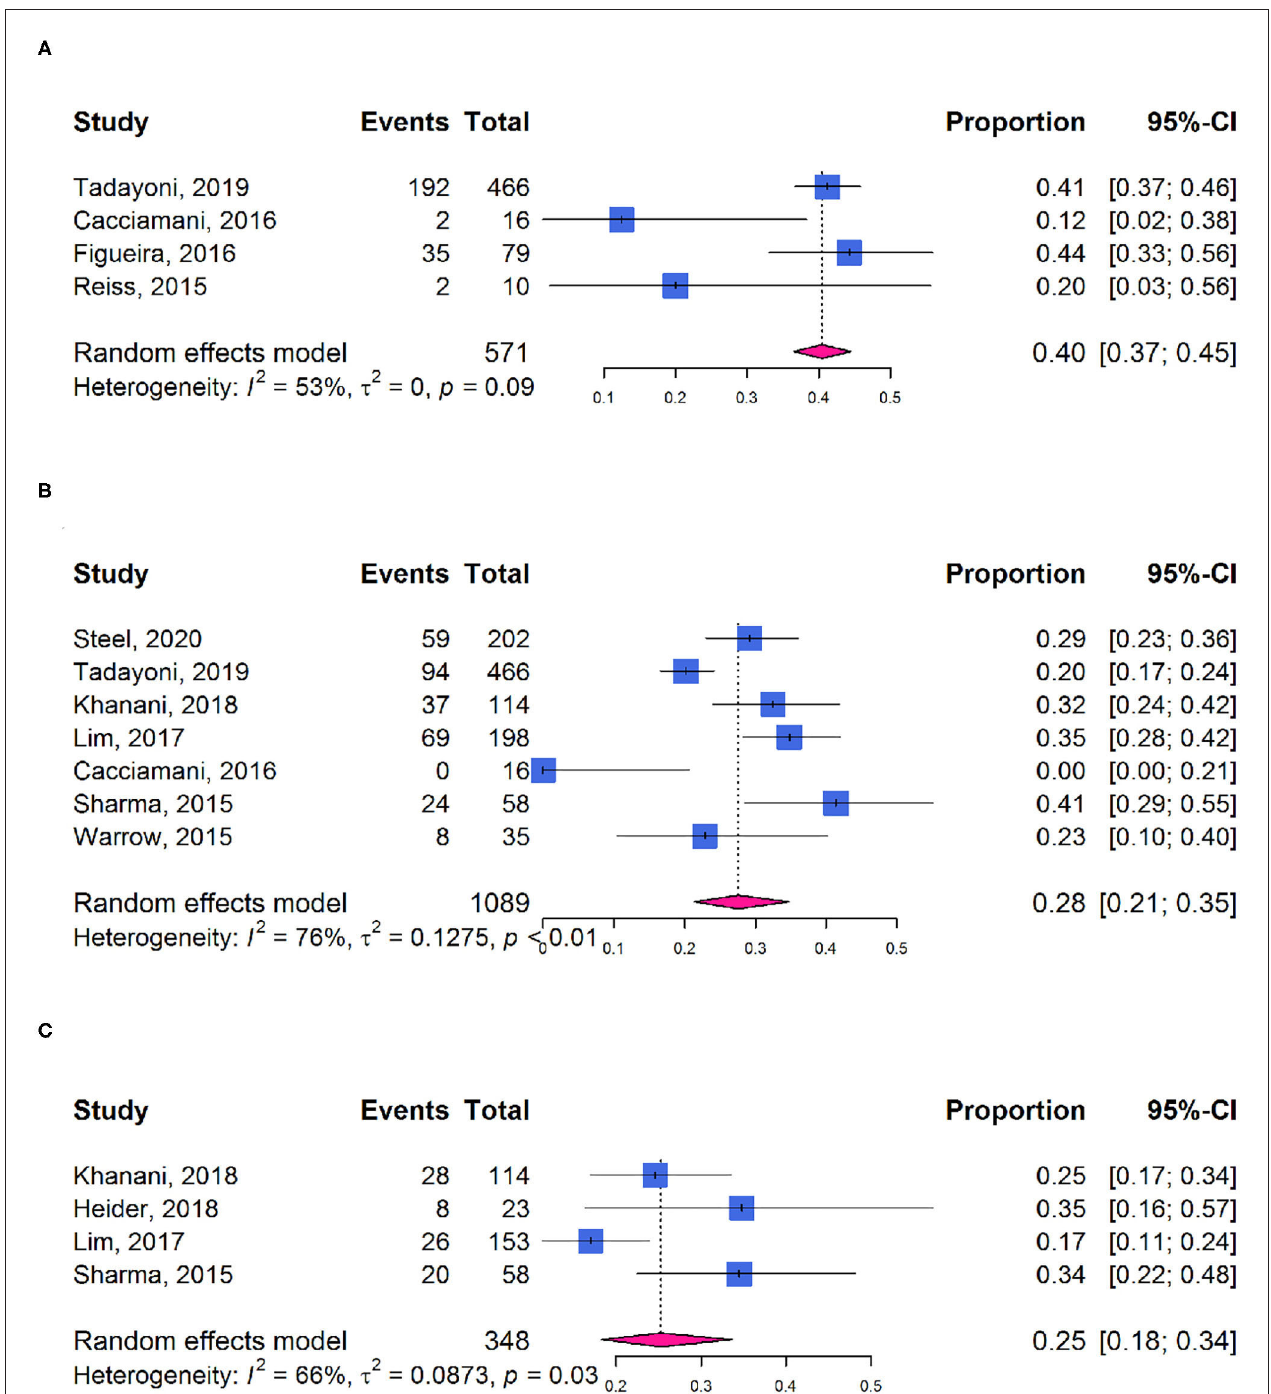
FIGURE 6 | Forest plots of proportion of visual acuity improvement in participants receiving ocriplasmin therapy. (A) ≥ 1-line improvement in BCVA; (B) ≥ 2-line improvement in BCVA; (C) ≥ 3-line improvement in BCVA.